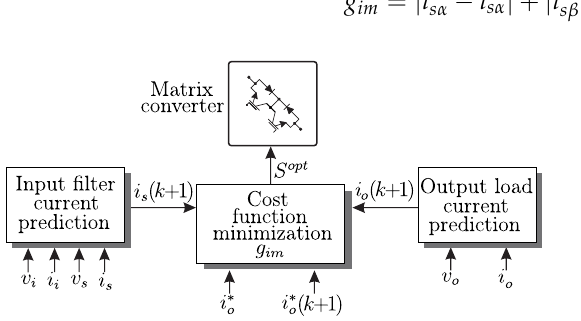
Figure 7. Predictive current control with imposed input current block diagram.